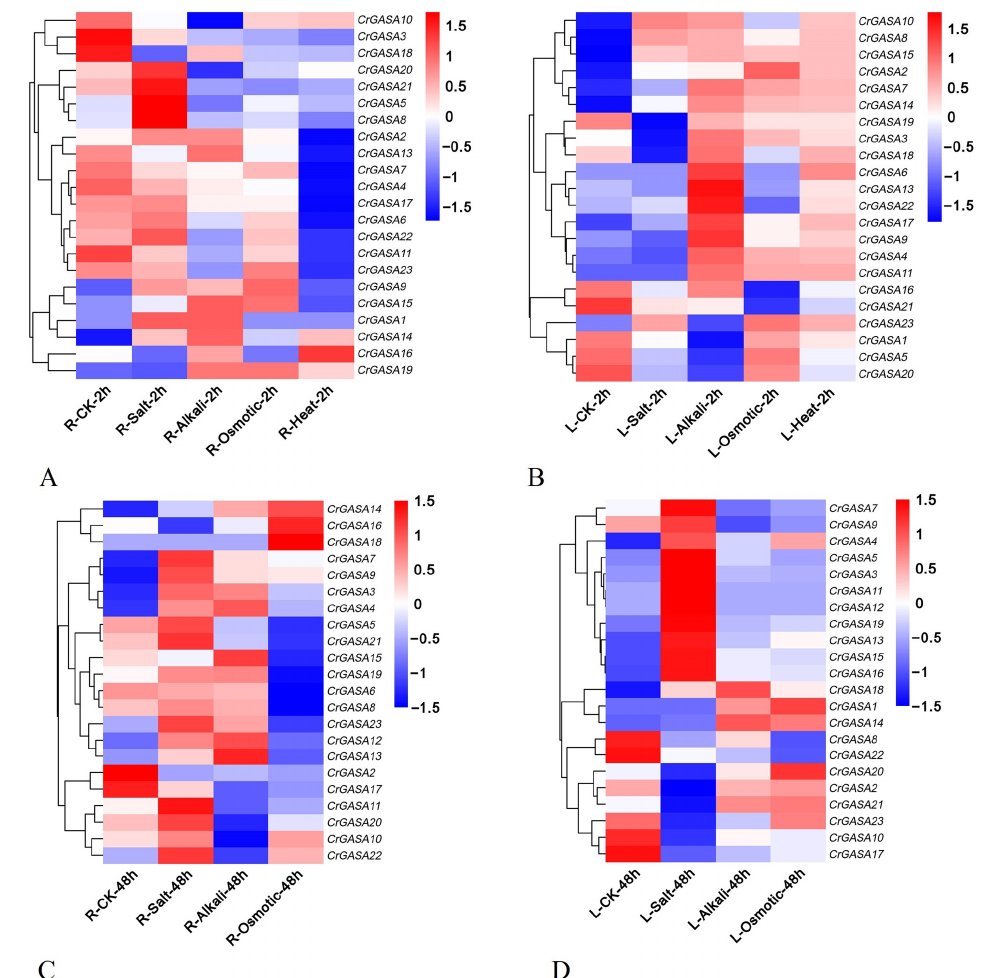
Figure 7. Heatmaps showing the expression changes of CrGASA s under high salinity, alkaline, high osmotic stresses, and heat challenge. ( A , B ) The expression differences of CrGASA s in the root ( A ) and leaf ( B ) after 2 h abiotic stress challenges; ( C , D ) the expression differences of CrGASA s in the root ( C ) and leaf ( D ) after 48 h abiotic stress challenges. CK: control. The expression level of each gene is shown in FPKM (log2). Red denotes high expression levels, and blue denotes low expression levels. Data normalization was performed on the Oebiotech Cloud website (https://cloud.oebi- otech.cn/task/detail/heatmap/ (accessed on 1 March 2022)).